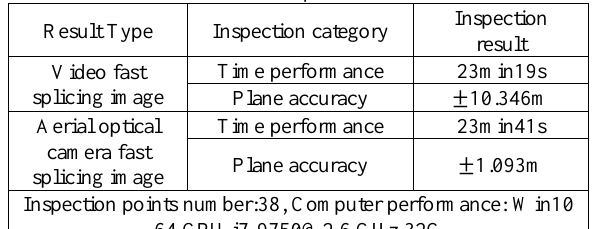
Table3. The inspection